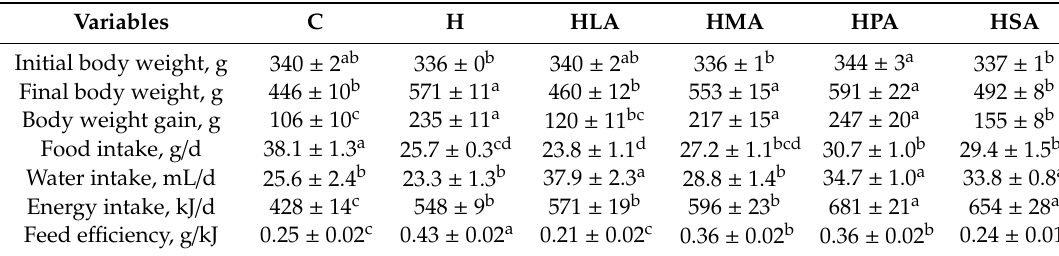
Table 1. Dietary parameters in rats treated with fatty acids.